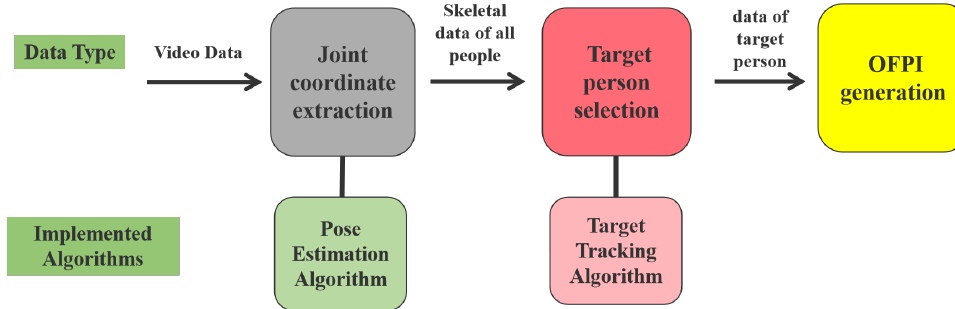
Figure 2. The overall pipeline of OFPI representation.